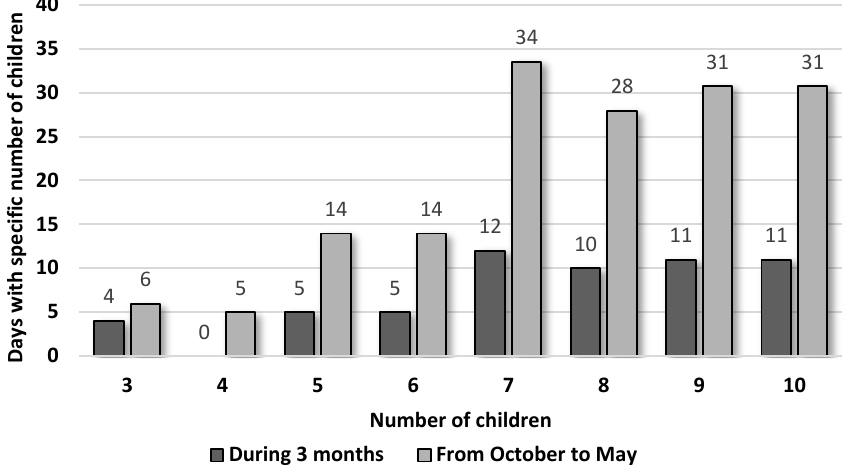
Figure 4. Assumed number of days with a defined number of children (3–10) during the work of ventilation, during 8 months